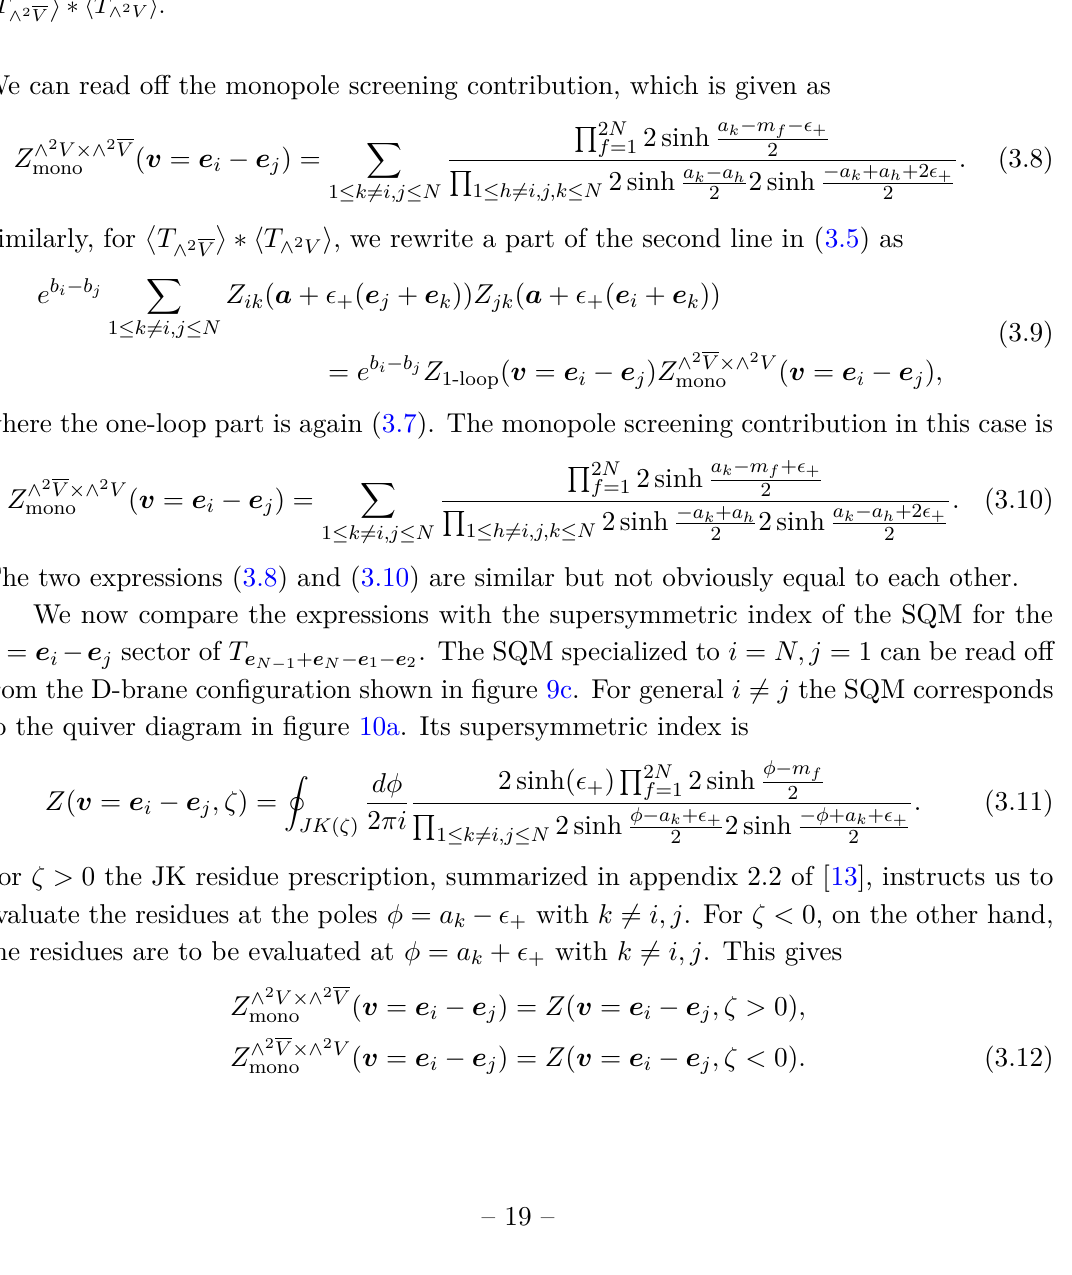
i ∗ h T i or ∧ 2 V ∧ 2 V